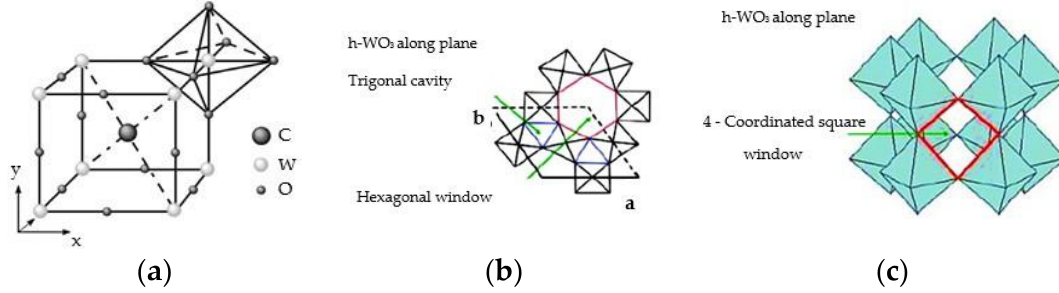
Figure 14. Crystal structure of СWO 3 perovskite: ( а ) general view; ( b ) h-WO 3 along plane; ( c ) h-WO 3 along plane.